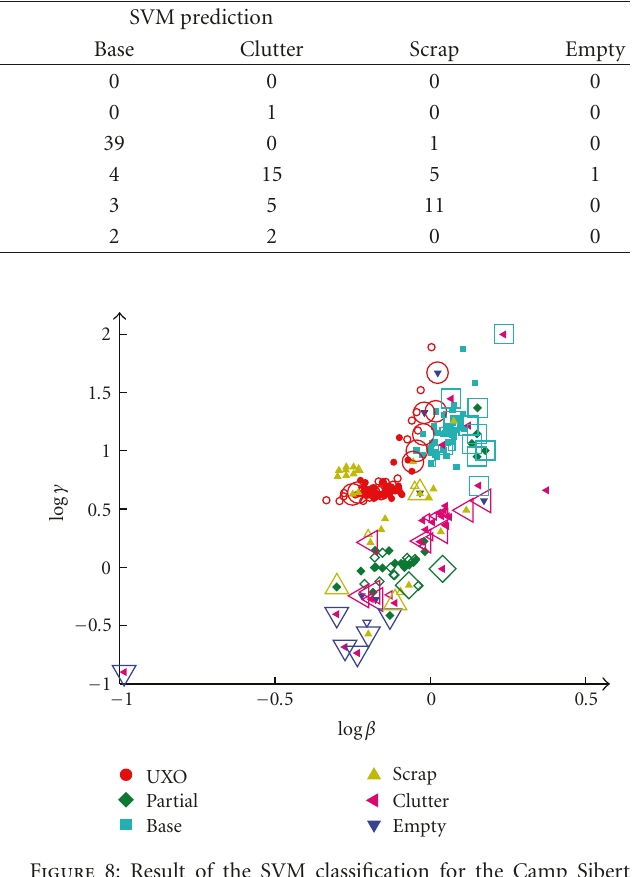
Figure 7: Result of the SVM classification for the Camp Sibert anomalies using the logarithms of the Pasion-Oldenburg parame- ters k and γ . The SVM here has a capacity C = 9. The small markers denote the ground truth for both training (hollow) and testing (solid) cells. The larger markers show the wrong SVM predictions.